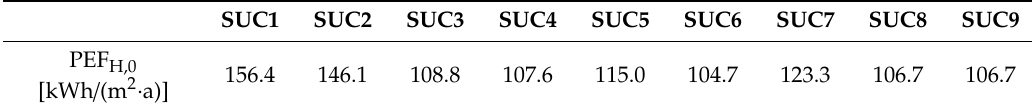
Table 4. Evaluation of energy savings and Primary Energy Factor for Heating after